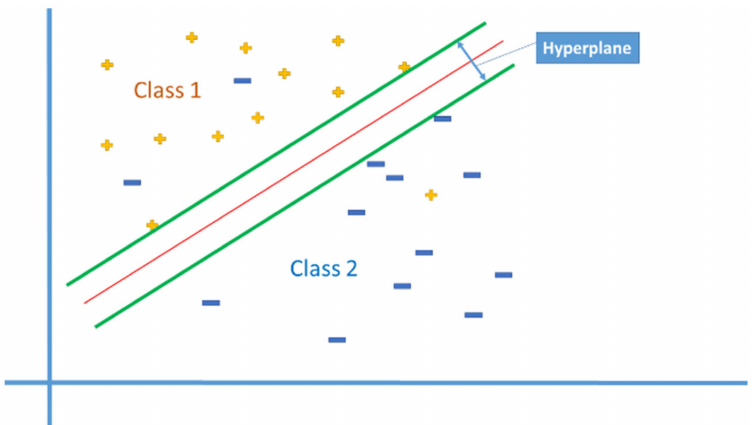
Figure 6. Graphical representation of support vector machine showing the maximum margin